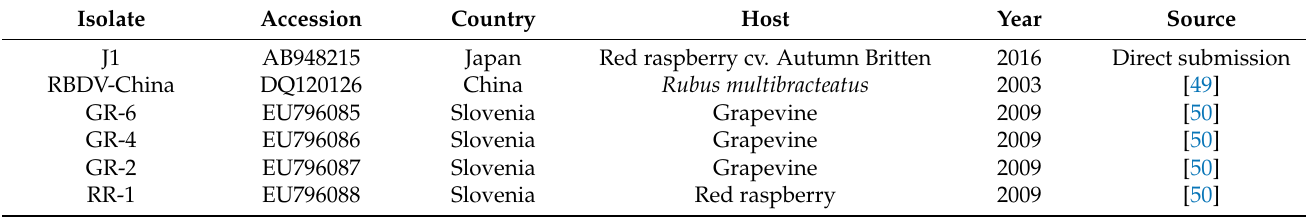
Table 2. Complete RBDV RNA2 sequences analysed in the present